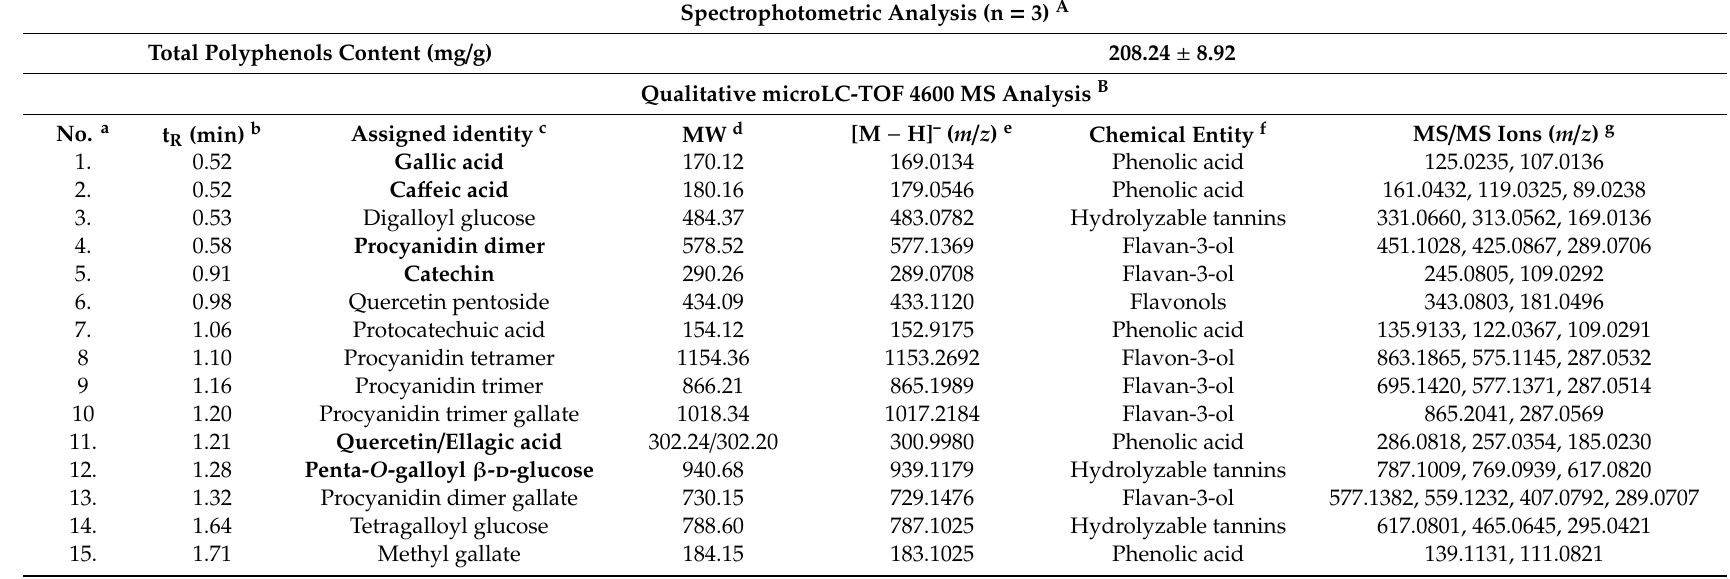
Table 1. Characterization of the polyphenol extract from defatted evening primrose